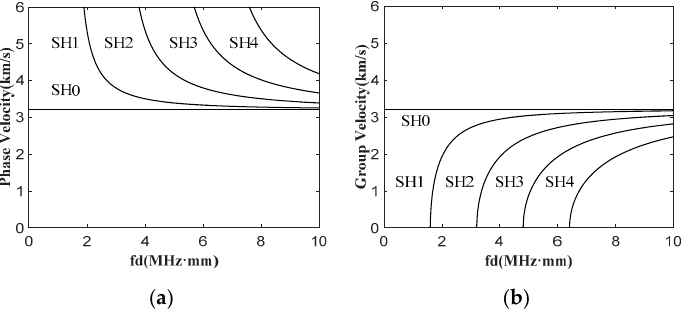
Figure 2. Dispersion curves of iron plates: ( a ) phase velocity curves; ( b ) group velocity curves.